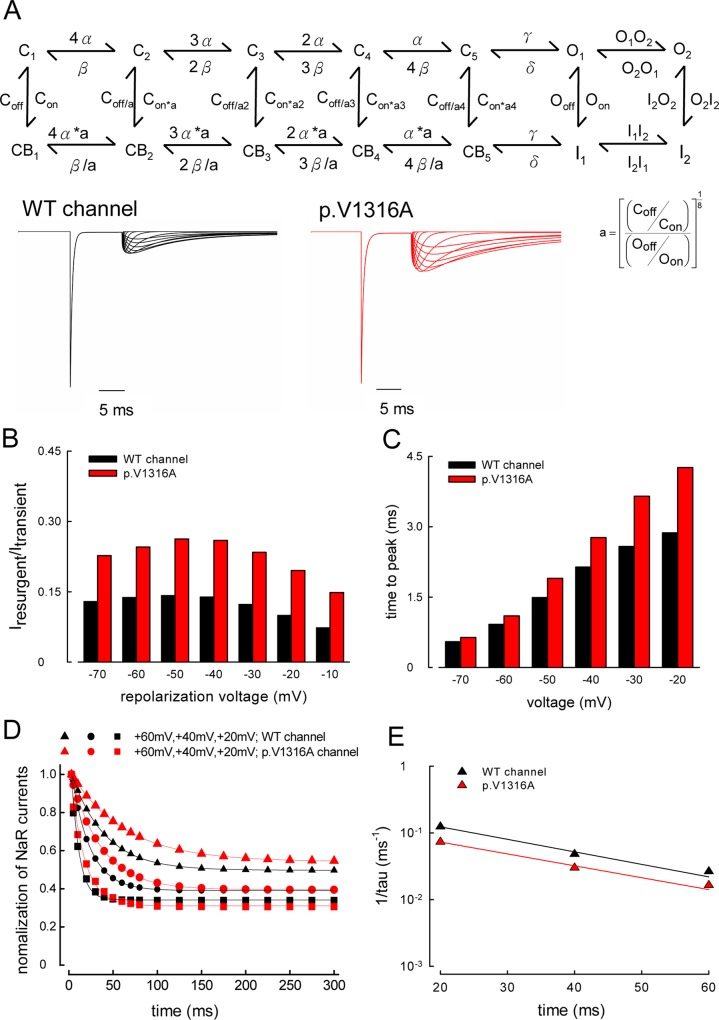
Computational simulations of resurgent Na+ currents in the WT and p.V1316A mutant channels.(A) The gating scheme and simulated currents of WT and p.V1316A mutant channels with the same stimulation protocols identical to that in Fig 5A and 5B. The peak of transient currents has been adjusted to be the same in both sets of the simulated currents. There are two open (O1 and O2) and two corresponding inactivated (I1 and I2) states. O2 and I2 are responsible for the genesis of resurgent currents and are significantly existent only in the presence of appropriate gating modifiers such as Navβ4 peptide (see Discussion for more molecular and biophysical details). The full set of kinetic parameters is provided in Table 1. In comparison with the WT channels, the main gating changes caused by the p.V1316A mutation include larger rate constants for α, β and I2O2, and smaller rate constants for O2I2, I1I2 and I2I1. (B) The peak amplitude of the simulated resurgent currents with the same protocols in Fig 5C. (C) The time to peak of resurgent currents was simulated with the same protocols in Fig 7C. (D) The decay of resurgent current with lengthening of the depolarization prepulse is simulated with the same experimental protocol in Fig 8. The lines are fits to the data points of the form: normalized resurgent currents = (1–fo)× exp(–(x–3)/τ)+ fo, where x is the prepulse length in ms. τ and fo are ~8.1 ms and 0.34 for +20 mV, ~20.8 ms and 0.39 for +40 mV, and ~37.8 ms and 0.49 for +60 mV prepulse, respectively, in the WT channel. On the other hand, τ and fo are ~13.6 ms and 0.31 for +20 mV, ~33.3 ms and 0.39 for +40 mV, and ~60.9 ms and 0.54 for +60 mV prepulse, respectively, in the p.V1316A mutant channel. (E) The inverses of time constants in part D are plotted against the prepulse voltage in semi-logarithmic scale. The data are fitted with the following equation 1/tau(V) = 0.29×exp(–1.1V/25) ms–1 for the WT channel, and 1/tau(V) = 0.17×exp(–1.03V/25) ms–1 for the p.V1316A mutant channel, respectively, where V is the prepulse potential in mV. Individual data is shown in the file of S1 Data.